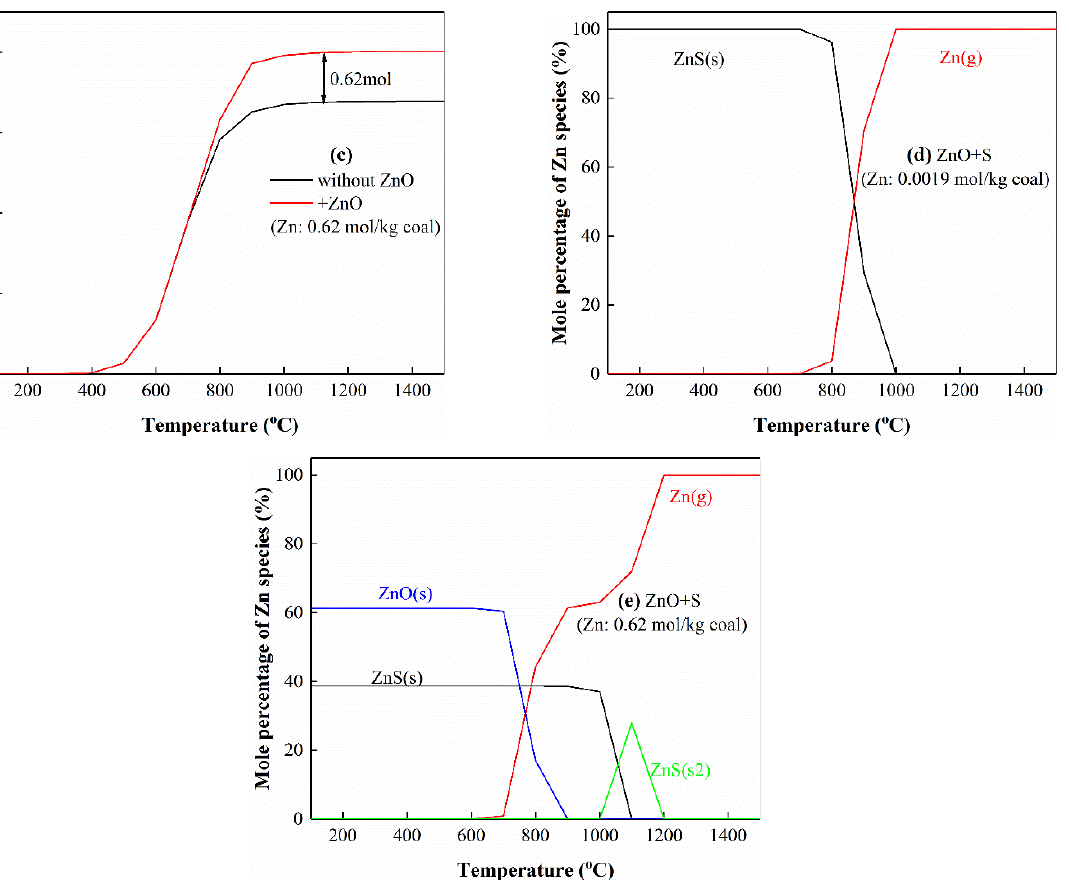
Figure 7. The thermodynamic equilibrium distributions of Zn ( a – e ) and generated amount of CO ( c ) when S and Zn coexist in the coal.